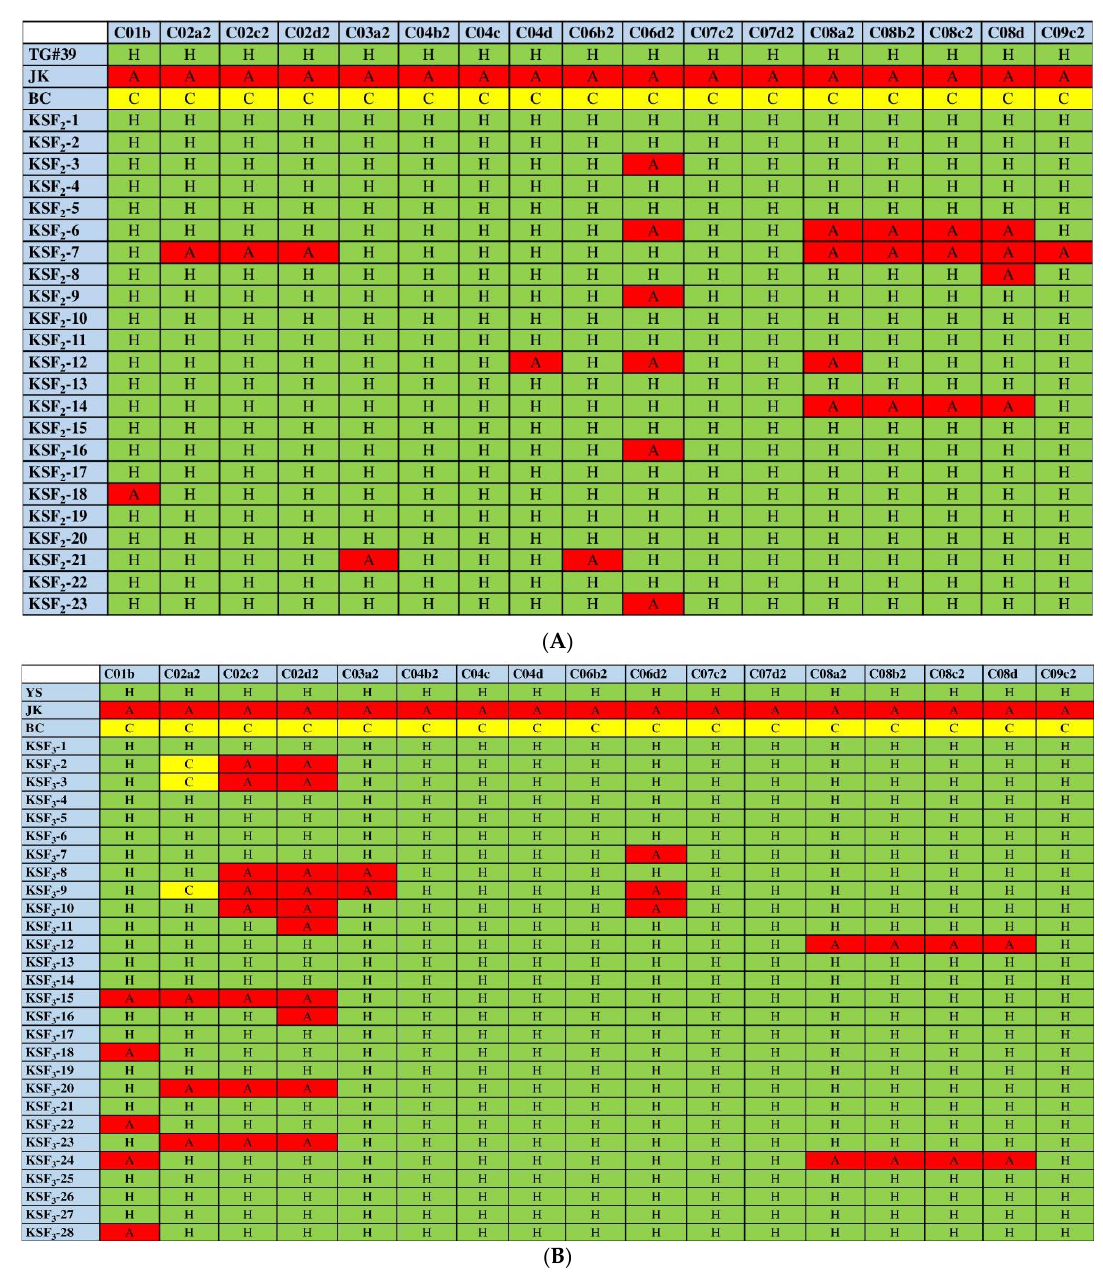
Figure 3. Chromosome segregation analysis by chromosome-specific SSR markers, which are indi- cated by bold alphanumeric characters in the first horizontal row. ( A ). F 2 generation of B. rapa ssp. rapa ( ♀ ) x GM B. napus ( ♂ ) (KSF). ( B ). F 3 generation of B. rapa ssp. rapa ( ♀ ) x GM B. napus ( ♂ ) (KSF). A, C, and H indicate the A chromosome, C chromosomes (highlighted in yellow), and hybrid-type bands, respectively. The C chromosome was identified and highlighted in green; the intergenomic recombination-induced loss of C chromosomal regions was identified and highlighted in red. Cluster analysis using the Jaccard distance matrix was used to evaluate the SSR marker data. The maximum distance was found in backcross generations (0.971), and a